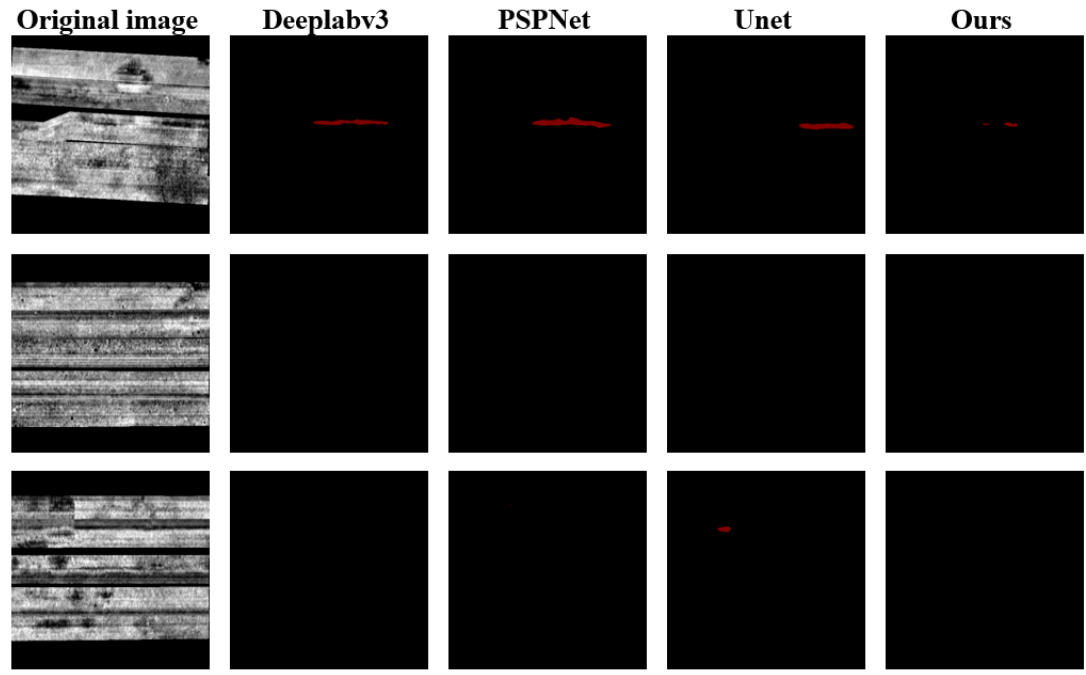
Figure 14. Comparison of segmentation diagrams among models in crack test set.